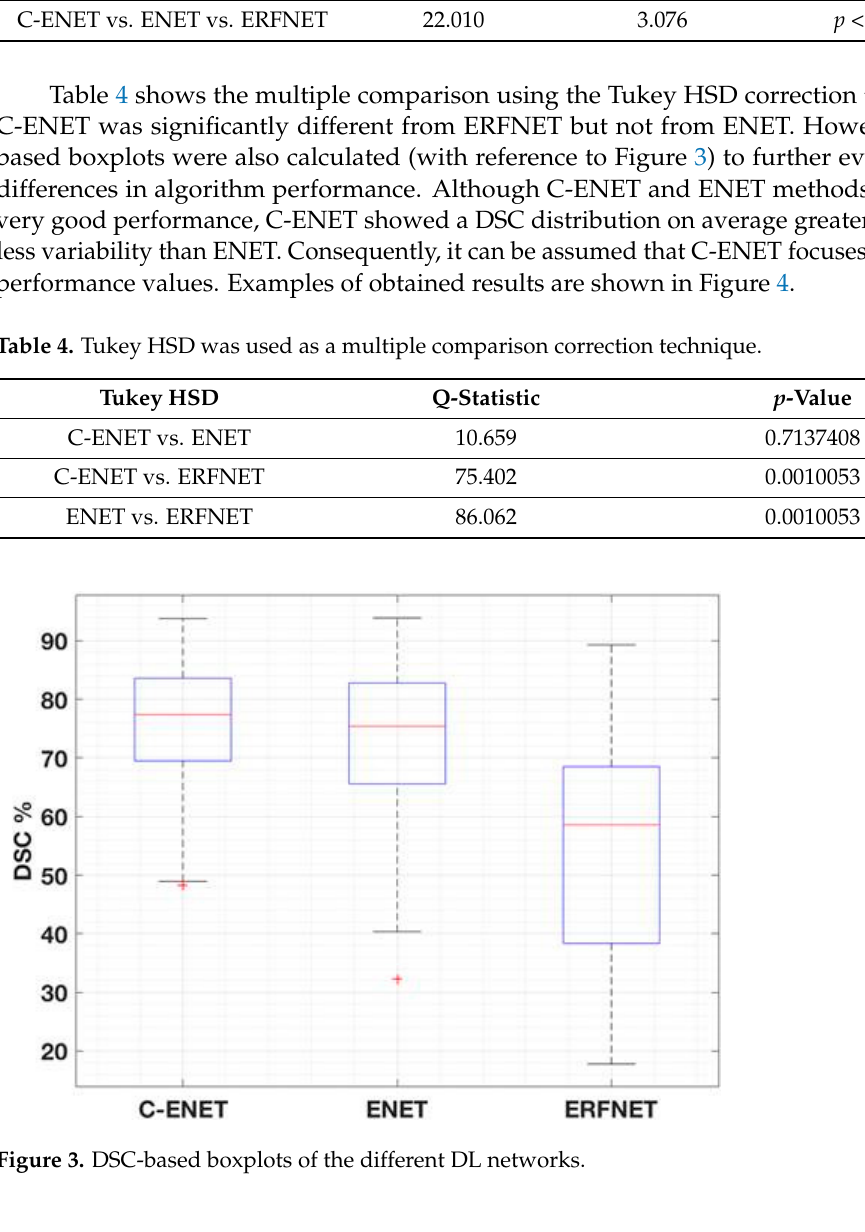
Figure 4. CT images showing parenchyma with visible subregions (yellow for the gold standard, red for C-ENET, green for ENET, and blue for ERFNET,) infected with COVID-19 disease.